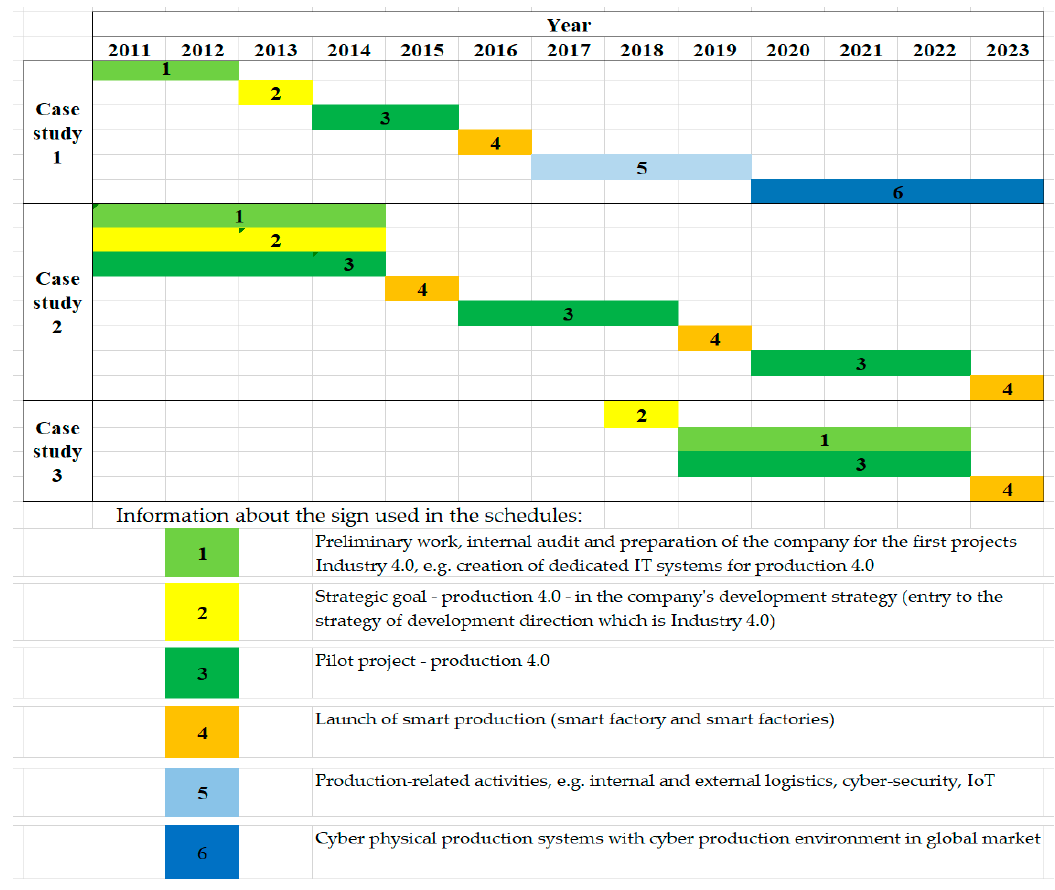
Figure 4. Schedule of work carried out in the enterprises (case studies 1–3). Source: own study.